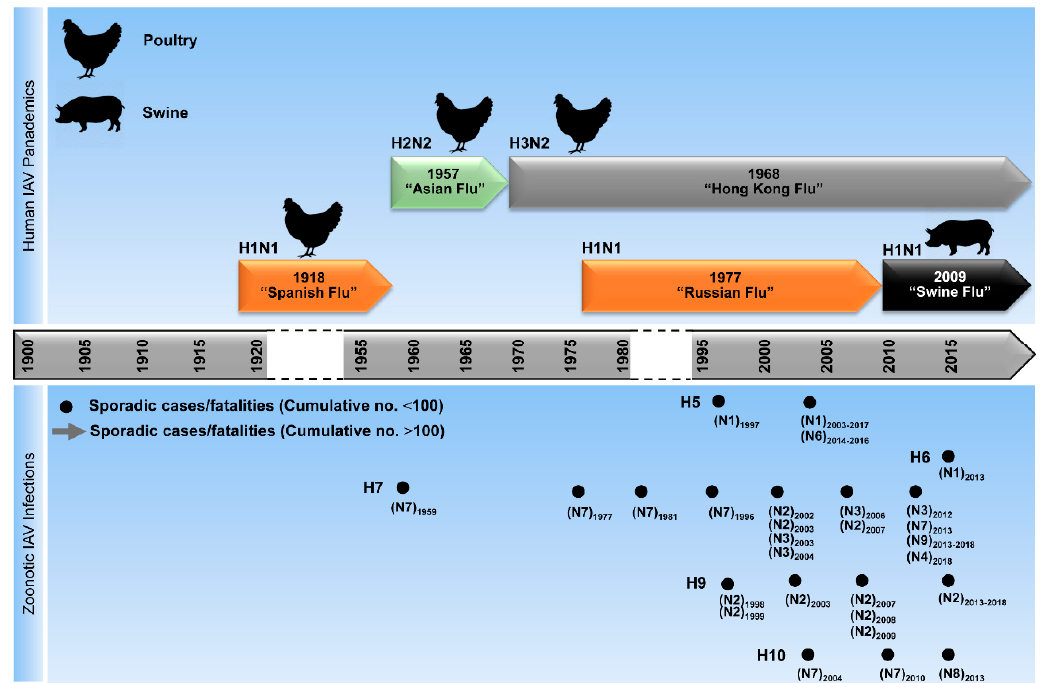
Figure 4. Timeline showing influenza pandemics and epidemics caused by IAVs. The “Spanish Flu” of 1918 was the most devastating influenza pandemic in the 20th century and was likely caused by a zoonotic transmission of an H1N1-type IAV from poultry to humans. This strain disappeared in 1957 when the influenza virus A/H2N2, a reassortant of the H1N1 virus and other avian IAVs, appeared and led to the second influenza pandemic—the “Asian Flu.” In 1968, H3N2, a novel reassortant strain between the H2N2-type and an H3-type virus, displaced the H2N2 strain in the human population and led to the “Hong Kong Flu”—the third influenza pandemic. In 1977 the H1N1 strain reemerged, resulting in the “Russian Flu”. In 2009, a new H1N1 reassortant was transmitted from swine to humans leading to the first pandemic of the 21st century—the “Swine Flu.” In parallel, different avian influenza A virus strains (H5-, H6-, H7-, H9-, and H10-types) have occasionally crossed the host barriers causing mild-to-fatal infections in humans.